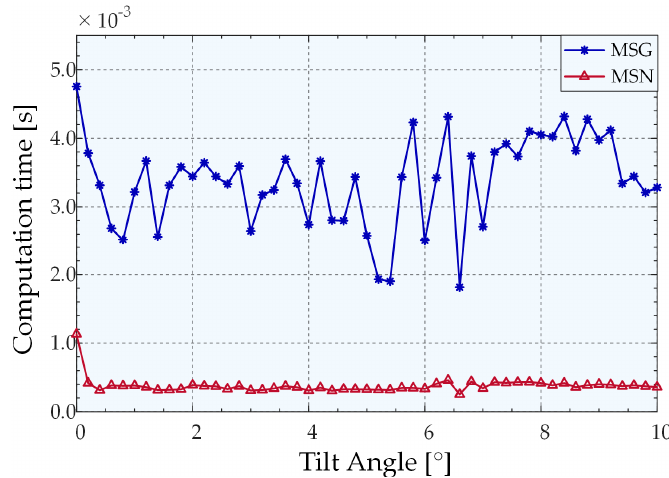
Figure 15. Extraction times of different algorithms.